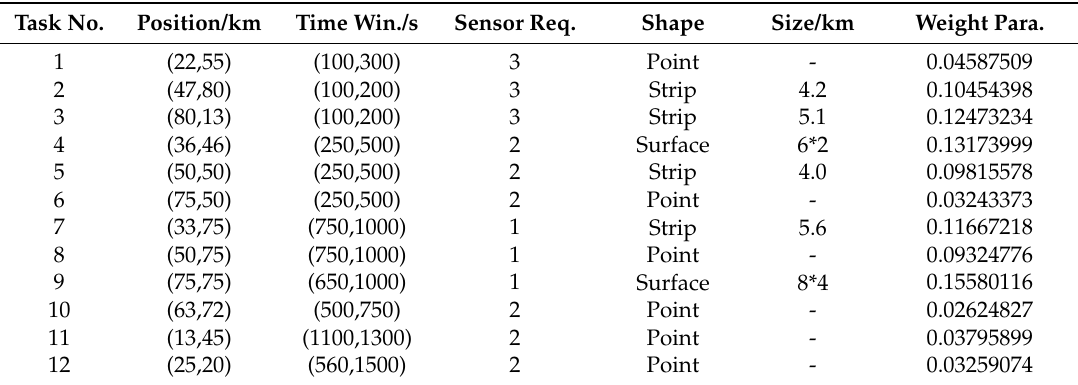
Table 3. Parameters of Task Point Parameters.